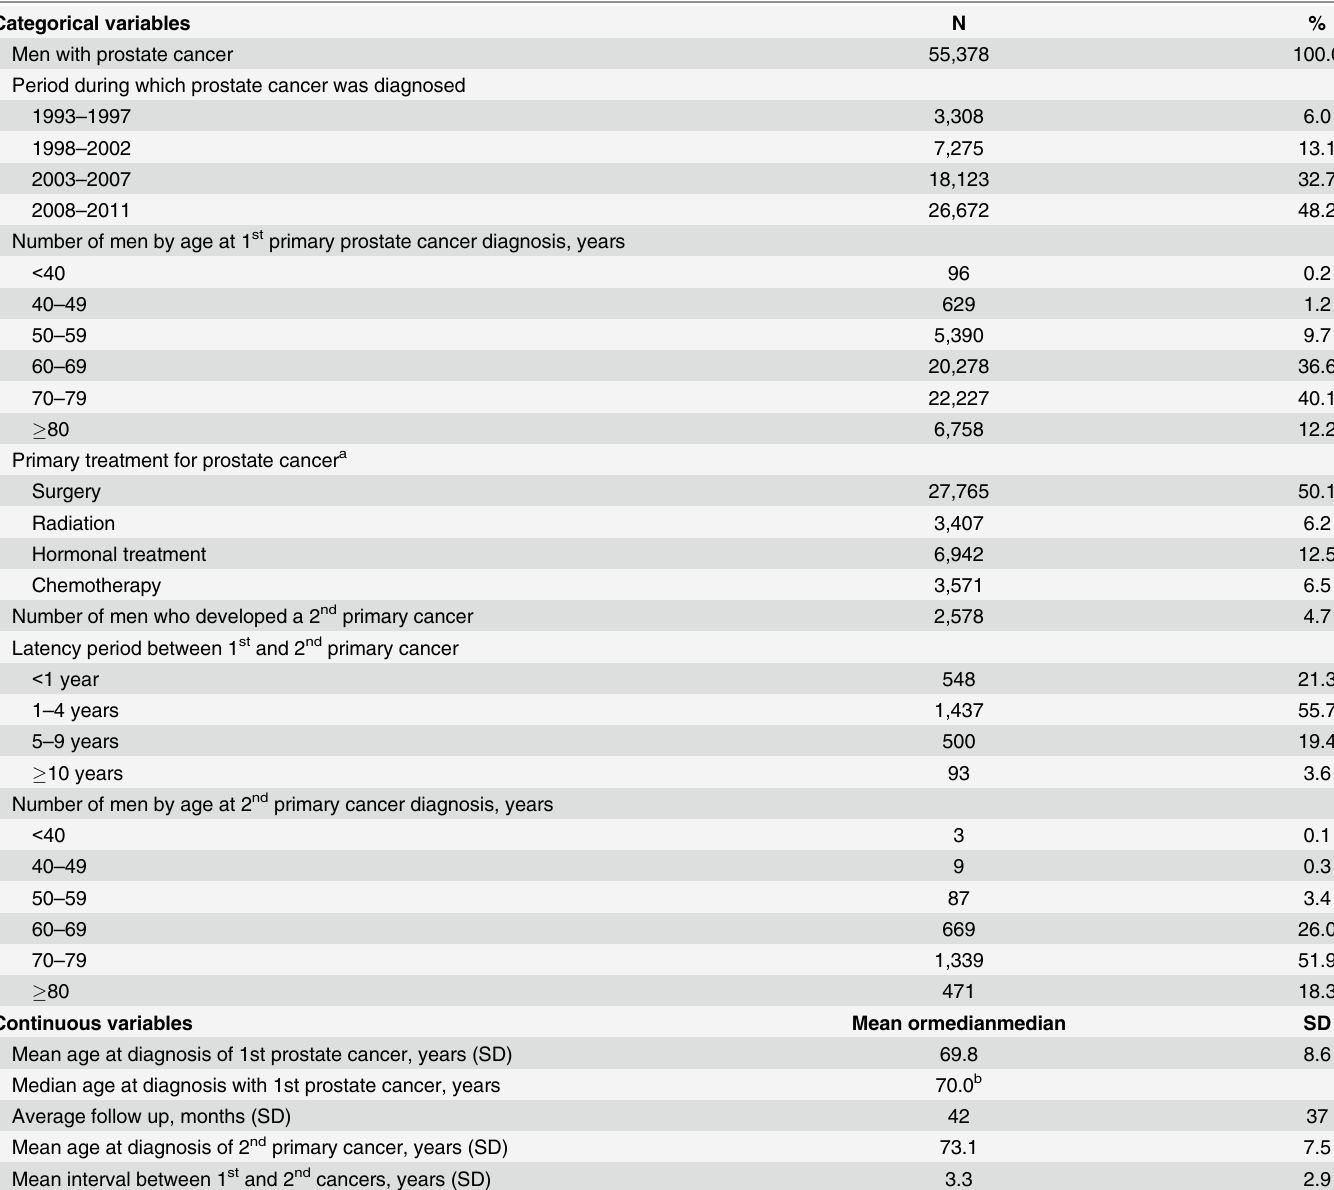
Table 1. Characteristics of patients with an initial cancer of the prostate diagnosed between 1993 and